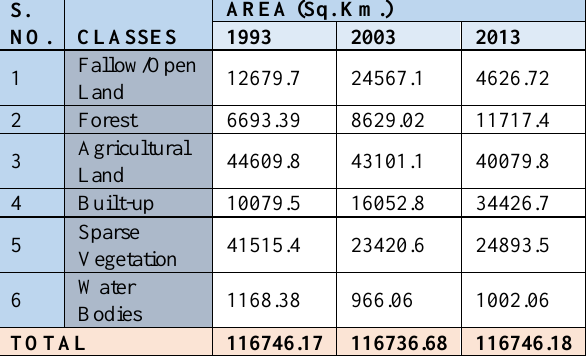
Table 5: Area Analysis of all Classes (Lucknow)